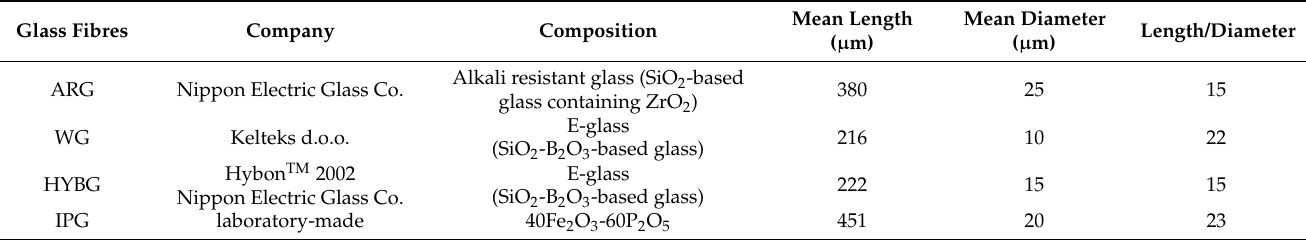
Table 1. The producer company, composition and mean length and diameter of glass